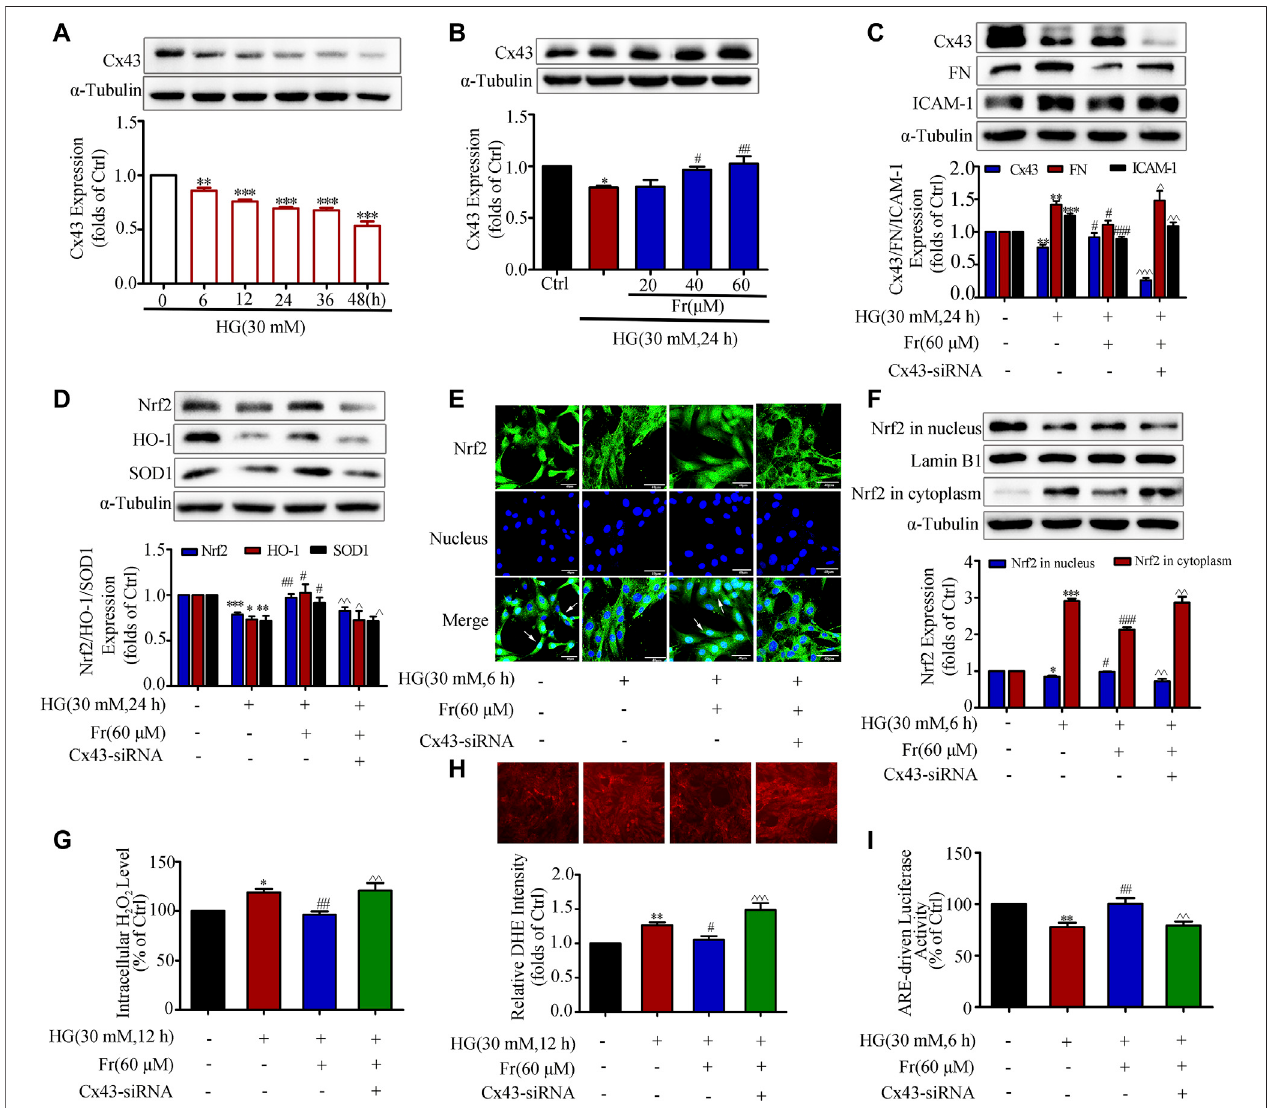
FIGURE4| FrpromotedNrf2nucleartranslocation byincreasingCx43expressioninHG-inducedGMCs. (A-B) ExpressionofCx43weredetected bythewestern blot assay in GMCs. (C-D) The protein levels of Cx43, FN, ICAM-1, Nrf2, HO-1 and SOD1 were detected by the western blot assay. (E) The subcellular distribution of Nrf2 in GMCs was measured by immuno fl uorescent staining (×600 magni fi cation). Bar: 40 μ m. Green fl uorescence indicated localization of Nrf2. (F) The western blot results shown the expression of Nrf2 in the nucleus and cytoplasm. (G) The H 2 O 2 levels in GMCs were detected. (H) The intracellular superoxide levels were detected by using the DHE probe. (I) Transcriptional activity of Nrf2 was determined by luciferase reporter assay. * p < 0.05, ** p < 0.01, *** p < 0.001 vs . Ctrl; # p < 0.05, ## p < 0.01, ### p < 0.001 vs . HG; ^ p < 0.05, ^^ p < 0.01, ^^^ p < 0.001 vs . HG with Fr. Independent experiments are performed at least three times with similar results.